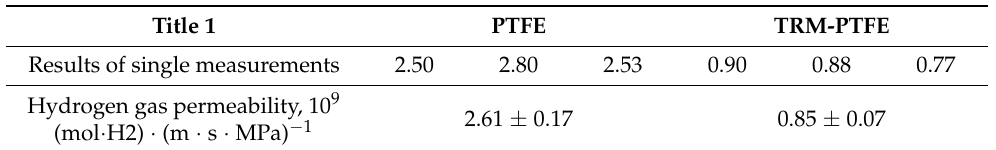
Table 1. Comparison of the hydrogen permeability of the films of the initial and thermoradiationally modified